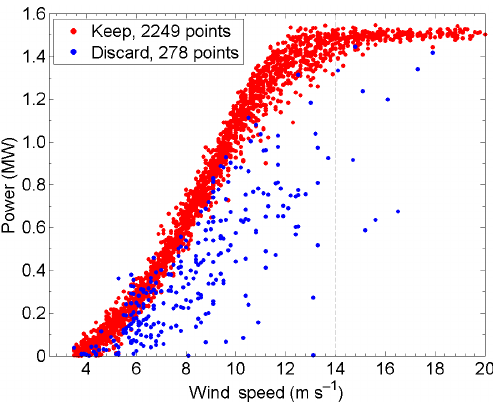
Figure 6. Scatter power curve using the tower 80m wind speed. Blue dots show points filtered out using turbine control parameters described in Sect. 3.3.2. Red dots show data points that passed this filtering process. The grey dashed line marks rated